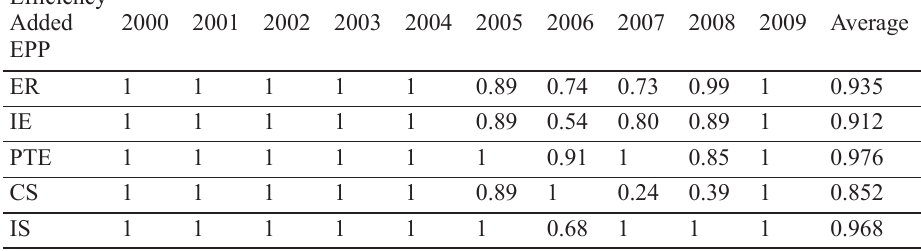
Table 3. The results of adding one input to DEA with ME as non discretionary and TA as discretionary input